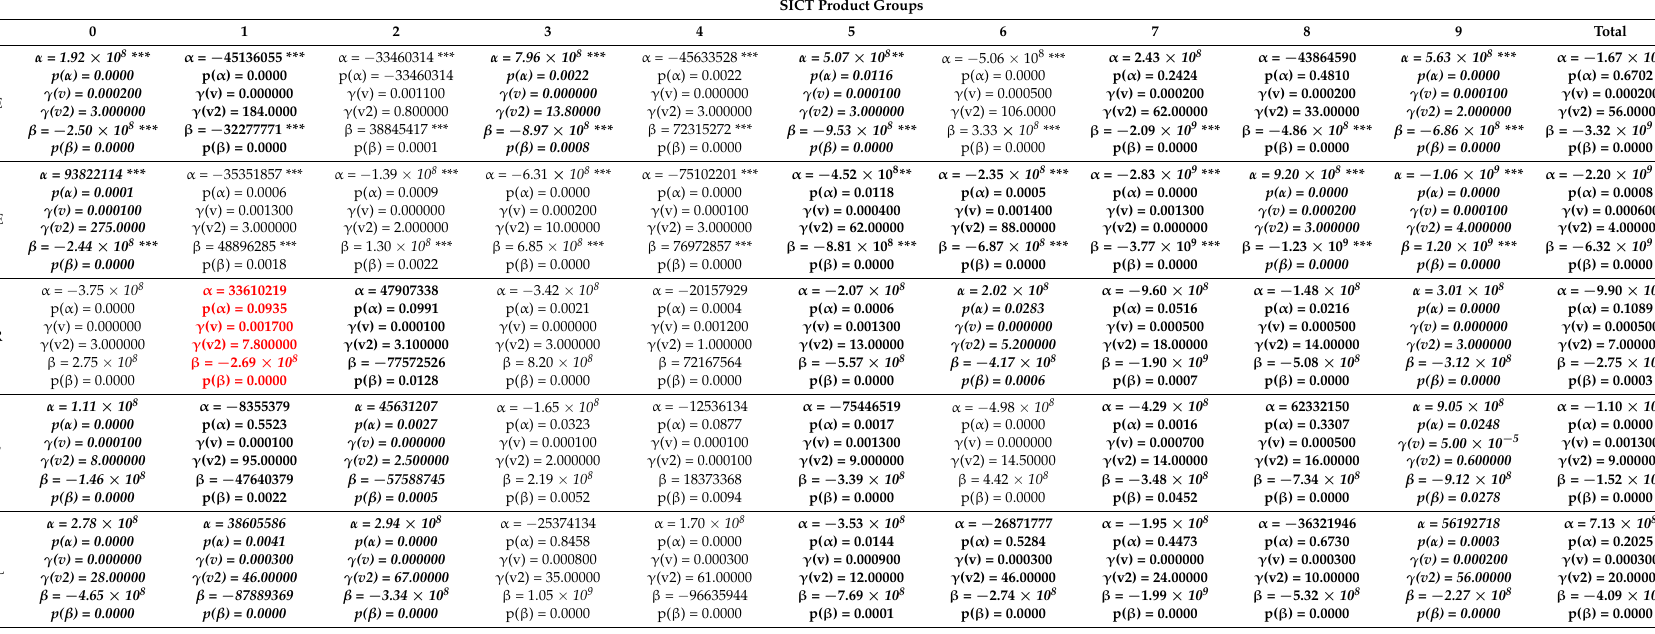
Table A7. Hysteresis with a variable play area and two uncertainty variables (EPUI,